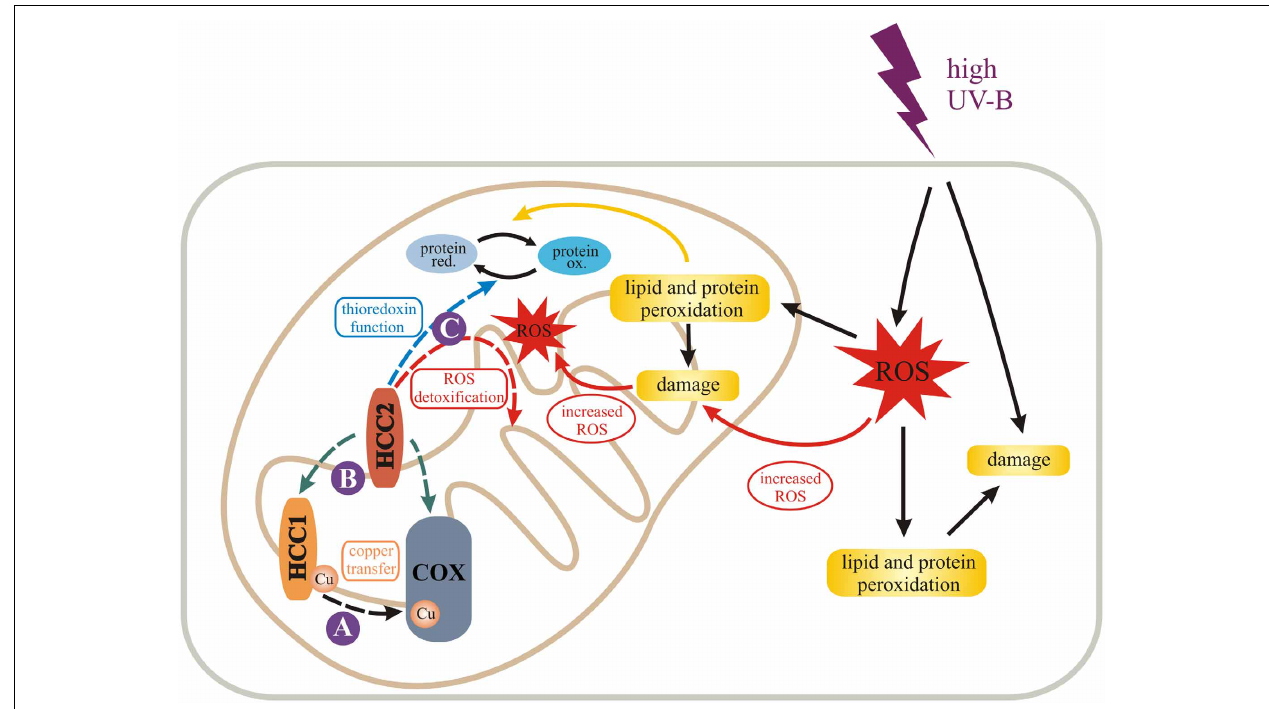
FIGURE 7 | Model for the role of HCC1 and HCC2 in plant mitochondria. We propose different functions (dashed arrows) for the two SCO proteins in mitochondria of A. thaliana indicated by solid purple circles. HCC1 is an essential plant protein and is most likely involved in copper transport to COX (complex IV) of the respiratory chain (A). HCC2 might have rather a slight influence on COX activity by either directly or indirectly supporting HCC1